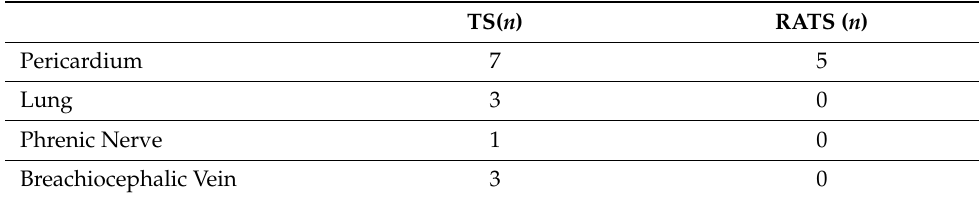
Table 5. Resected adjacent